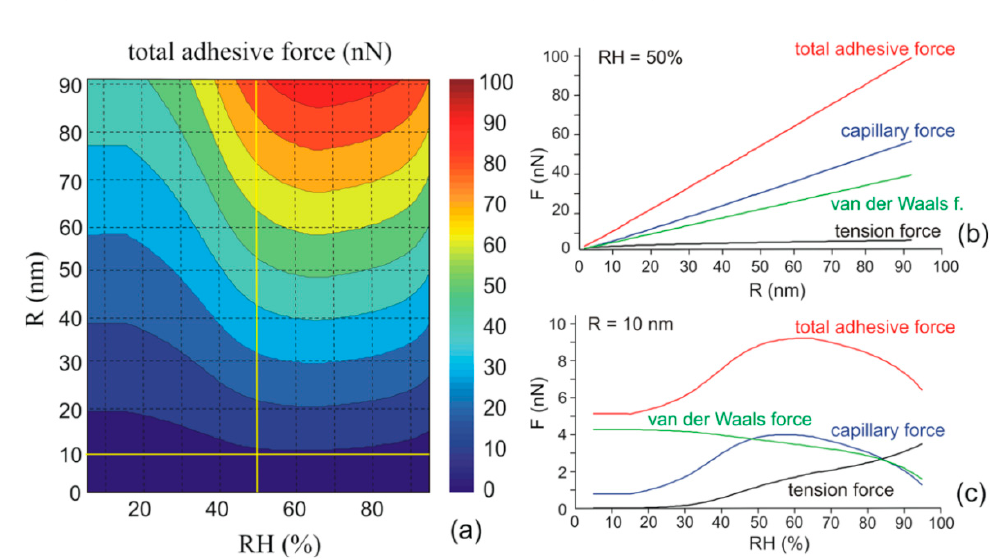
Figure 13. ( a ) The calculated total adhesive force between Si 3 N 4 AFM tip and hydrophilic silicon substrate as a function of the tip radius and RH for water − surface and water − tip contact angles θ 1 and θ 2 = 40°. ( b ) The profiles of the total adhesive force and its constituents for 50%RH and ( c ) a tip radius of 10 nm. Reprinted from Ref. [93], Copyright 2017, with permission from ACS publications.